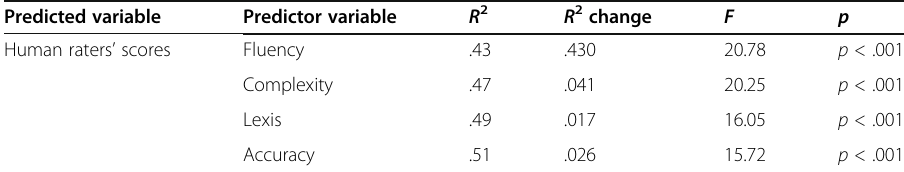
Table 9 Multiple regression analysis results using analytical CAF as predictors of human raters ’ evaluation